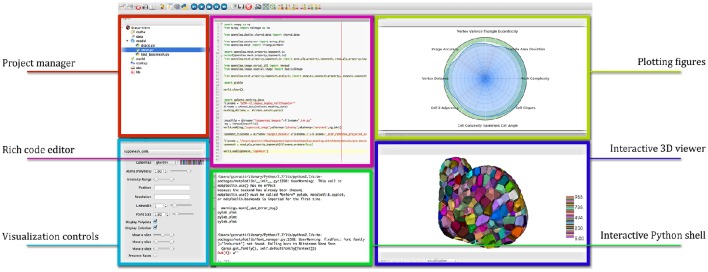
Interaction with a cellular complex mesh in the TissueLab model development platform.